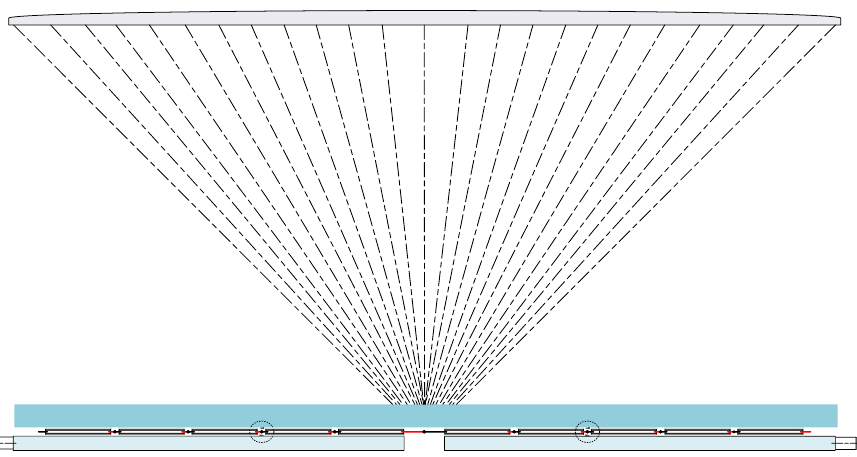
Figure 4. Fresnel lens and the TEG panel (side view). In our experimental work, a Fresnel lens focused light on a single spot. A glass cover and an aluminum plate ensured an approximately uniform distribution of heat on the hot side of the TEG panel. The entire design was experimentally implemented as shown in Figure 5.